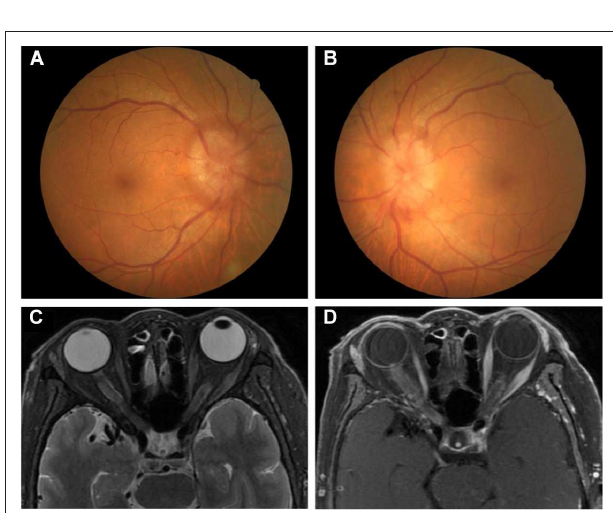
FIGURE 3 | (A,B) Fundus examination in Case 2. Bilateral optic disc oedema. (C,D) Orbital MRI in Case 2. (C) Bilateral optic nerve enlargements of orbital and inner canal segments in T2-weight imaging. (D) Bilateral leptomeningeal enhancement in optic nerves when gadolinium was administered (“tram-tracking”